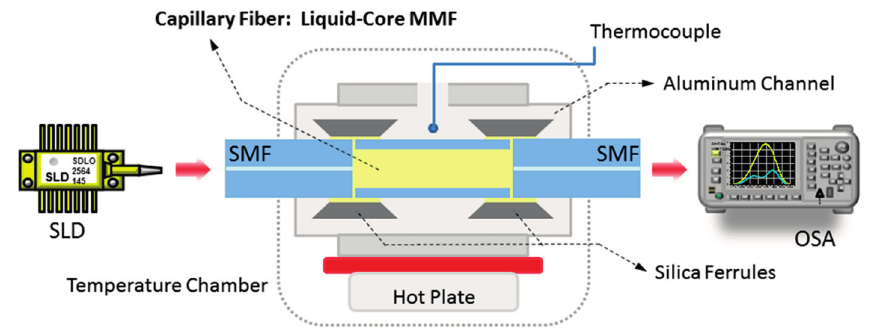
Figure 3. Schematic of the liquid-core temperature sensor based on MMI effects.